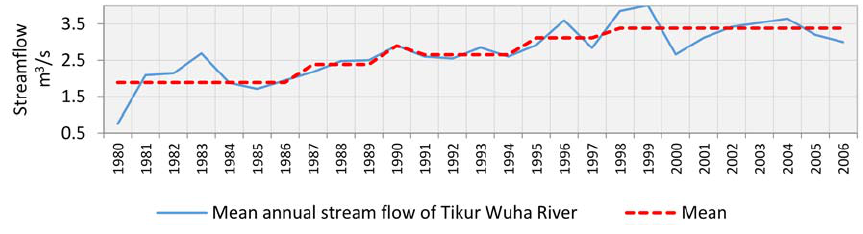
Figure 6. Regime shift in Tikur Wuha streamflow.